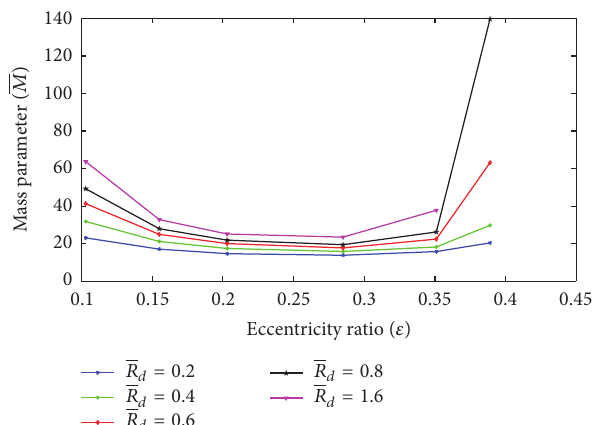
Figure 12: Effect of relief track depth ratio on mass parameter.